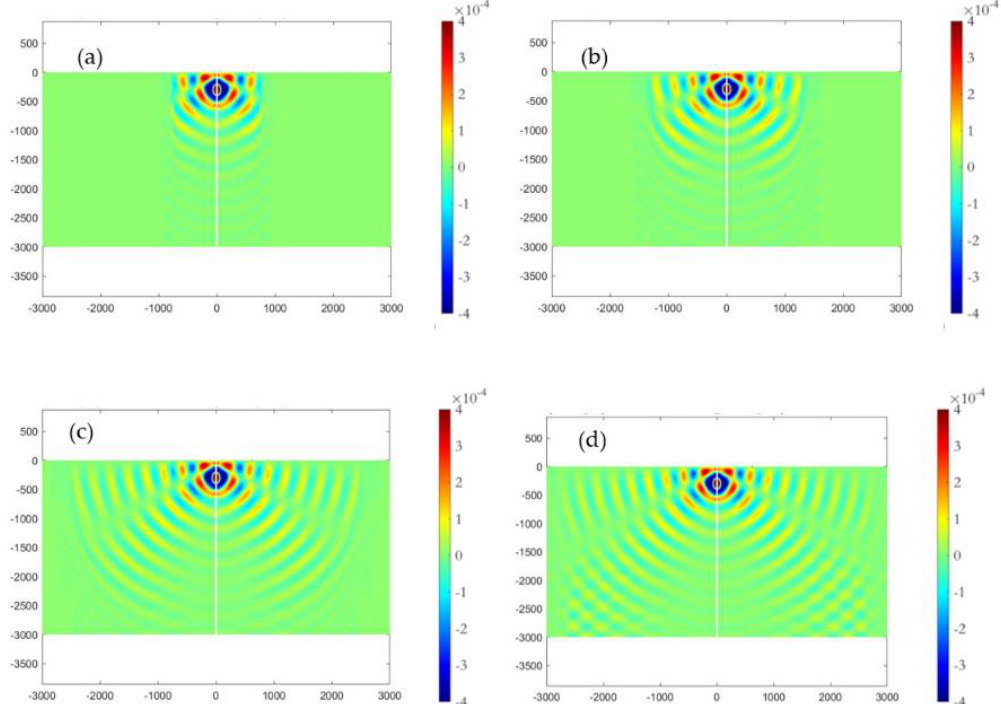
present FDTD method.